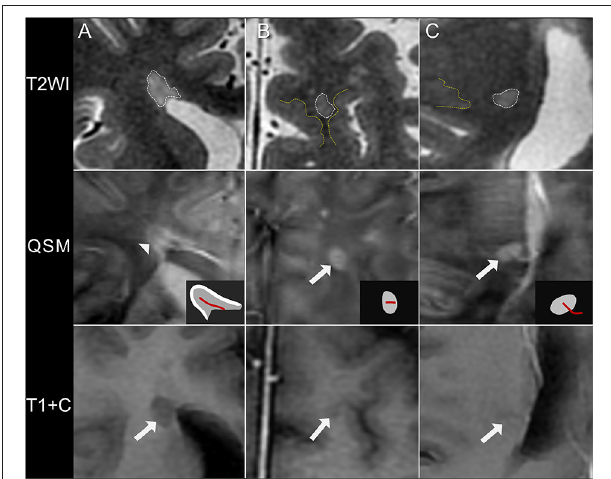
FIGURE 1 | Quantitative susceptibility mapping (QSM) patterns of MS lesions. (A) A rim + periventricular MS lesion. T2WI shows a hyperintense lesion abutting the lateral ventricles without white matter in between. A hyperintense rim is found on the lesion edge on QSM (arrowhead), as illustrated in the diagrams (white region). (B) A rim– juxtacortical lesion. T2WI shows a hyperintense lesion located near the cortex, with a distance < 3mm from corticomedullary junction (yellow line). The lesion is nodular hyperintense on QSM with no hyperintense rim (arrow). (C) A rim– deep white matter lesion. The lesion is located far away from both the cortex (yellow line) and the lateral ventricle and is hyperintense on QSM with no rim (arrow). These lesions are non-enhancing on axial T1WI after injection of contrast agent (T1 + C), suggesting of a chronic status. QSM shows a hyperintense vein passing through the lesion center (the central vein sign), as illustrated in the diagrams (red